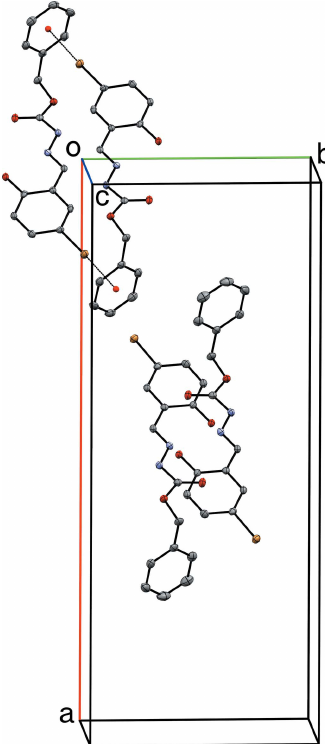
Figure 7 In spite of their similar conformations, inversion-related pairs of II A molecules (upper) are different from inversion-related pairs of II B molecules (lower). For II A there are close contacts between bromine and the inversion-related benzene ring, as shown by the dotted line. No such interaction exists for II B